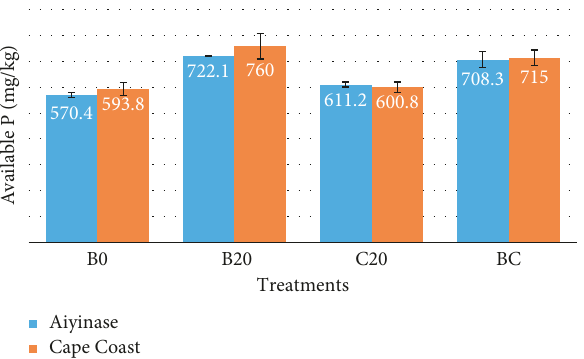
Figure 3: Changes in soil total organic carbon of Aiyinase and Cape Coast soils following application of corncob biochar and/or compost 14 days after incubation. B0 � control with no amendments; B20 � biochar 2%, w/w; C20 � compost 2%, w/w; BC � combined biochar and com- post rate 1% compost+1% biochar. Error bars represent standard deviation of the